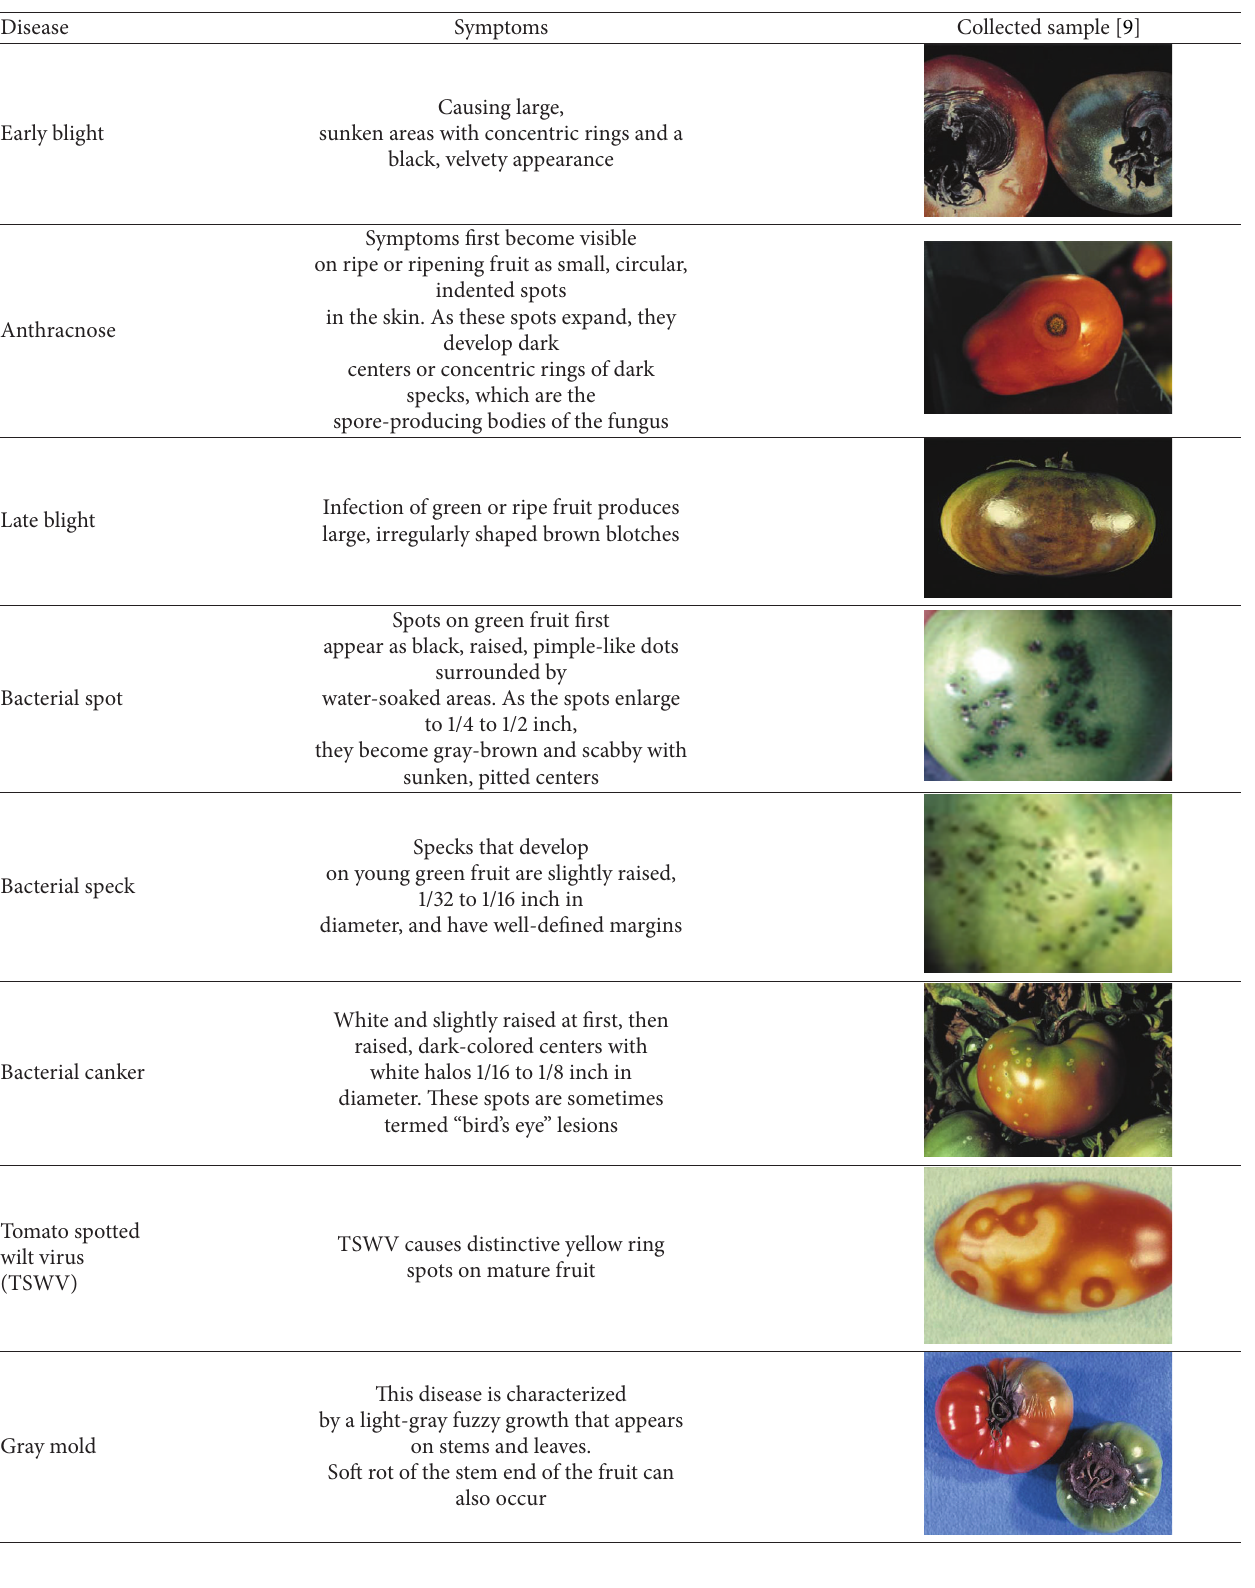
Table 2: Database prepared for infected tomato samples for disease detection and classification.